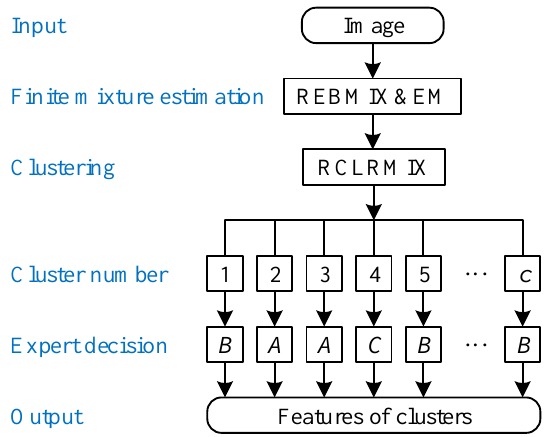
Figure 3. Training of image